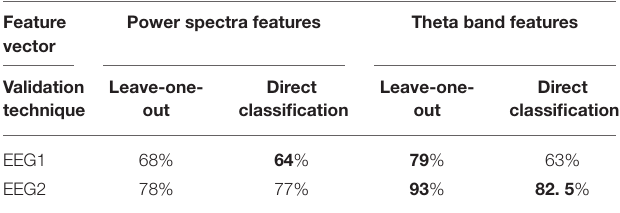
TABLE 5 | All given accuracies are the result of the Monte Carlo